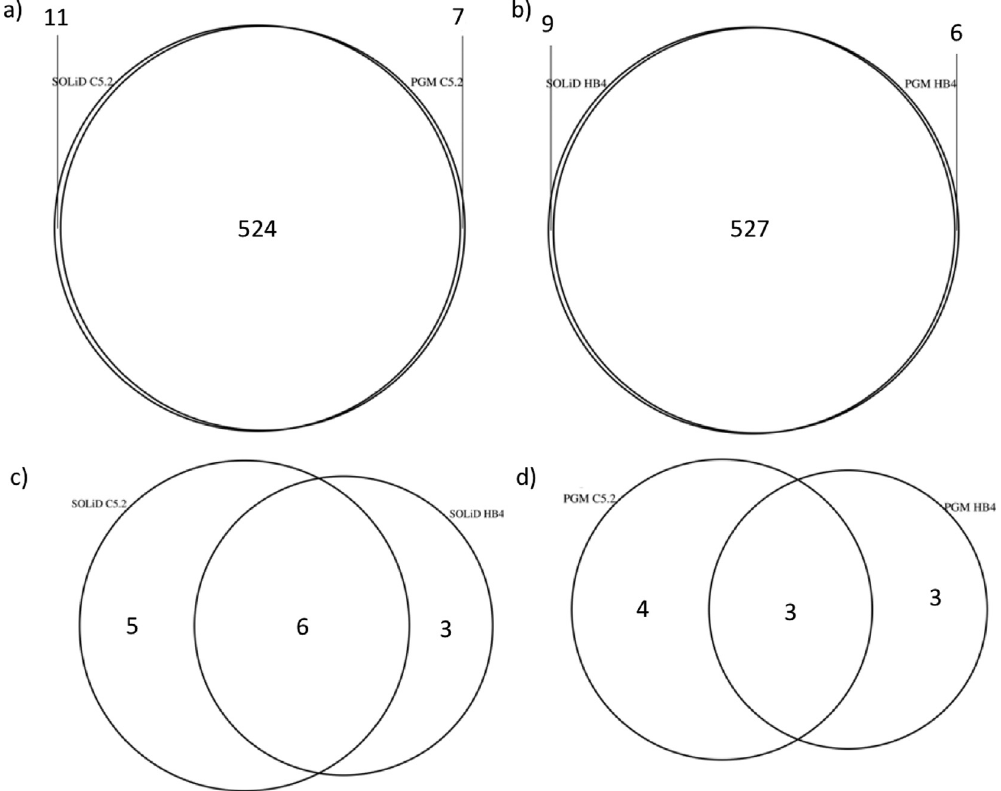
Figure 3 - Venn diagrams depicting the sets of miRNAs preferentially represented in C5.2 (a), or HB4a (b) cell lines using SOLiD or PGM platforms. miRNAsmoreabundantlyrepresentedinSOLiD(c),orPGM(d).ThemiRNAsindicatedherecorrespondtothoseindicatedbyreddotsinFigure2andto the last two lines of Table